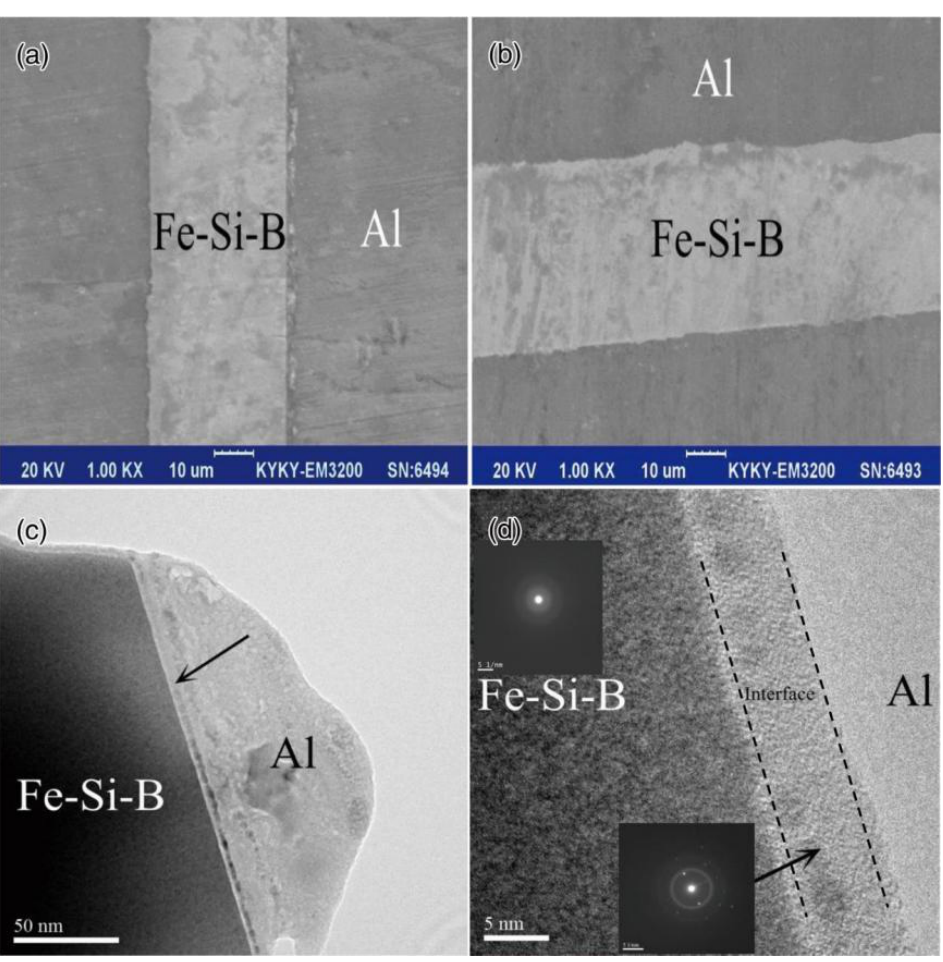
Figure 5. SEM photos of the interface of the composite wafer synthesized by high-pressure torsion at 10 GPa and TEM photo of the interface of the composite wafer synthesized by high-pressure torsion for 4 turns at 1.10 GPa. ( a ) Twist 1 turn; ( b ) twist 4 turns; ( c ) bright field image of the interface; ( d ) high-resolution image of the interface marking the selected area electron diffraction pattern (the crystalline characterization of Al can be seen in the below inset pattern of the selected area’s electron diffraction, along with the amorphous halo in the same inset pattern).